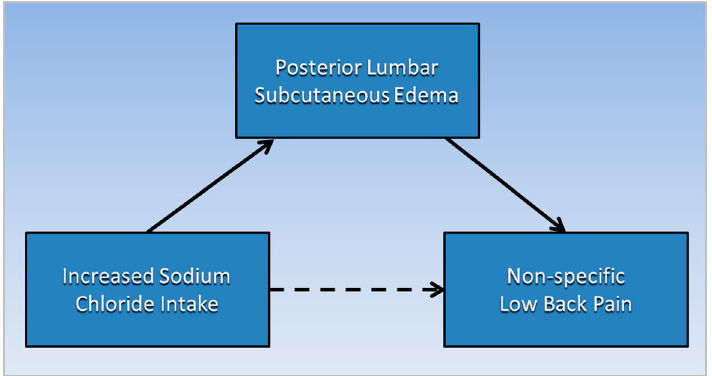
Figure 2. Posterior lumbar subcutaneous edema potentially mediates the association of increased sodium chloride intake with non-specific low back pain.